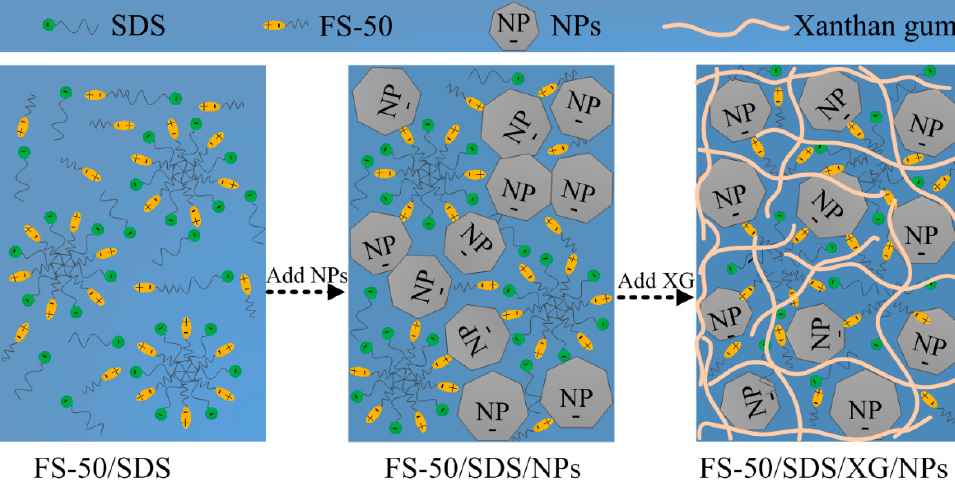
Figure 2. Schematic diagram of the molecular interaction in bulk dispersions. XG is an anionic polymer, which is negatively charged in water [37]. Silica NPs are also negatively charged in water [38]. SDS is anionic, and FS-50 is zwitterionic. Hence, Coulomb forces existed in the same charged molecules of FS-50/SDS/NPs/XG [39]. In addition, opposite attraction existed between the zwitterionic FS-50 and the negatively charged SDS/NPs/XG. The complicated and intense molecular interactions led to the molecular interactions with SDS/FS-50/NPs dispersions than with NPs